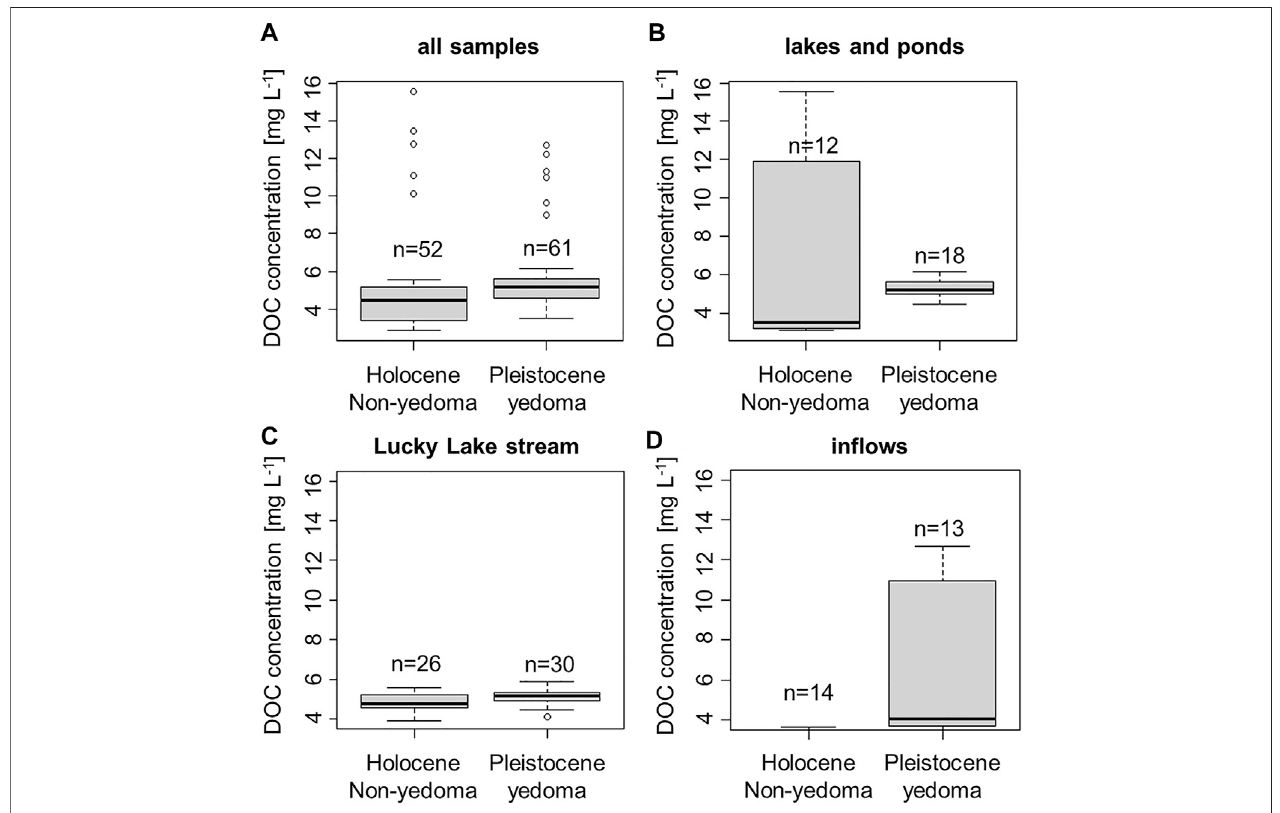
FIGURE 3| Comparison ofDOC concentrations of (A) all samples in the Lucky Lake catchment, (B) samples from lakesand ponds, (C) samples from Lucky Lake stream,and (D) fromin fl ows;byHolocenenon-yedomaandPleistoceneyedoma. Thegreyishshadedboxesrepresentthestandarddeviationfromthemean(solidline).